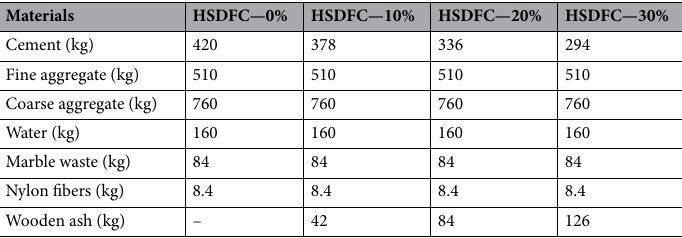
Table 6. Mix proportion of